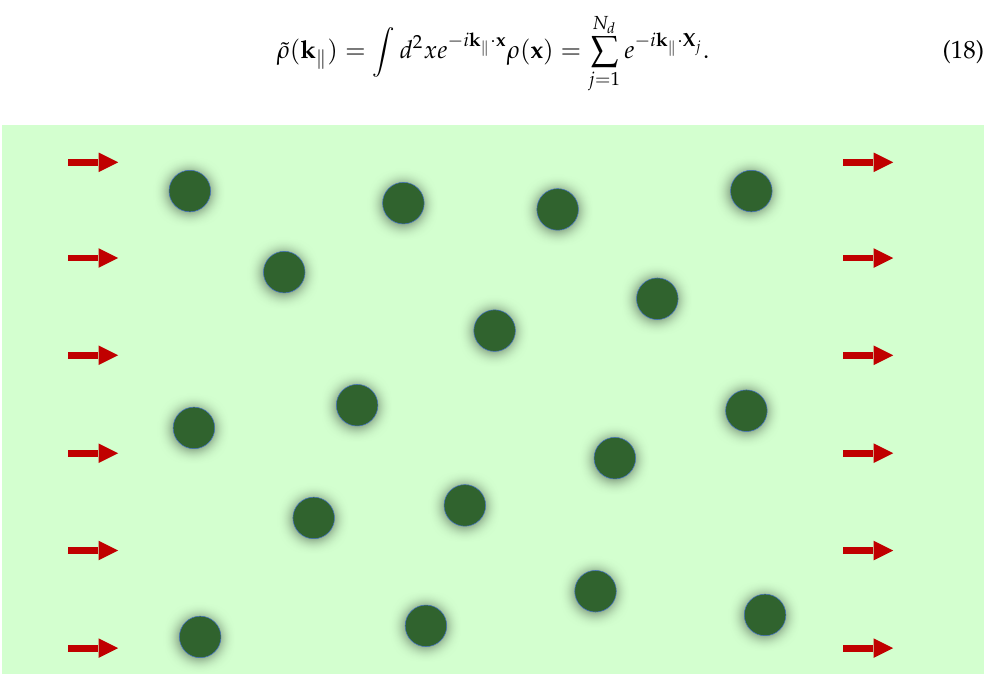
Figure 3. Random distribution of torsional dislocations seen from a plane perpendicular to the cylinder